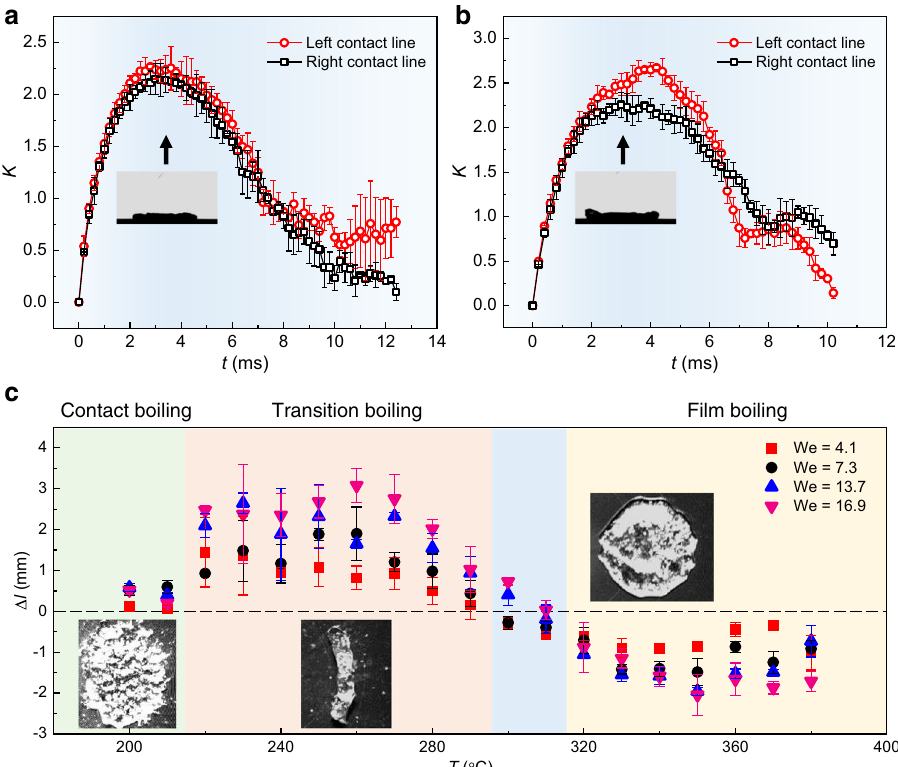
Fig. 2 Displacement of the contact line and the drop. a , b Variation of contact line length ratio K of an impinging drop on concentric microgroove arrays ( r = d /4) on the left (red) and right (black) sides under We = 16.9 at T = 250 and 350 °C, respectively. The insets in a , b represent the side view of maximum spreading. c Lateral displacements Δ l of bouncing drops as a function of temperature under various Weber numbers. A positive Δ l , i.e., Δ l L , indicates that drops rebound towards the center of curvature, while a negative one, i.e., Δ l R , towards the opposite direction. The insets show the recoiling of impacting drops shortly after they reach the maximum spreading at different boiling states. The error bars of the data in a – c denote the standard deviation of three measurements. Source data are provided as a Source Data fi